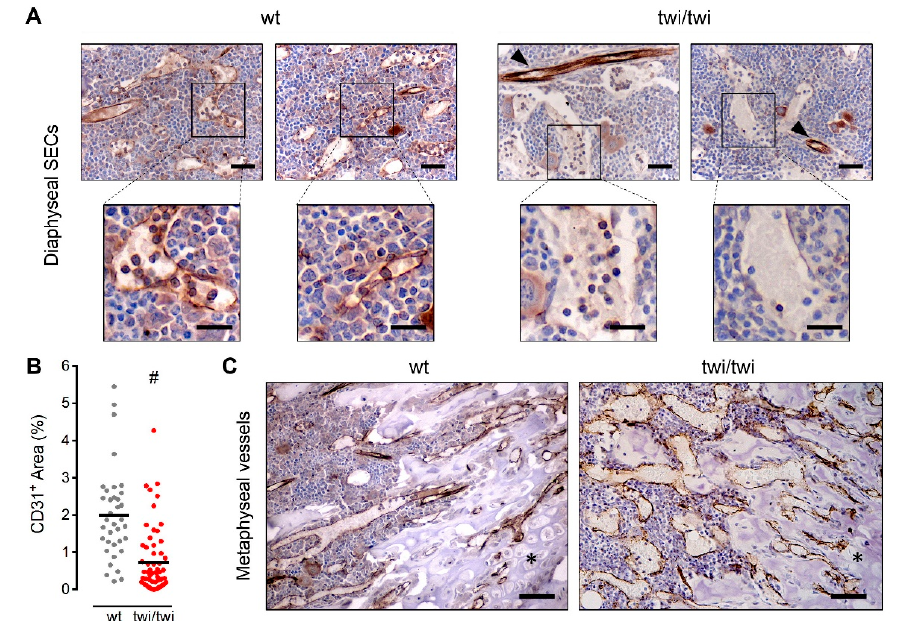
Figure 2. BM diaphyseal twitcher SECs do not express CD31. CD31 immunohistochemical staining of femurs from wt and twitcher mice. ( A ) CD31 expression in diaphyseal SECs of two wt and two twitcher mice. Arrowheads indicate CD31 + arterioles. Scale bar: 50 μ m. Scale bar in magnified fields: 30 μ m. ( B ) Quantification of CD31 + area in femoral histological sections. Dots represent the percentage area occupied by CD31 + vessels in different microscopic fields. Horizontal black bars show the mean value. #, p < 0.001. ( C ) CD31 expression in metaphyseal vessels. Asterisks indicate the cartilaginous tissue. Scale bar: 100 μ m.